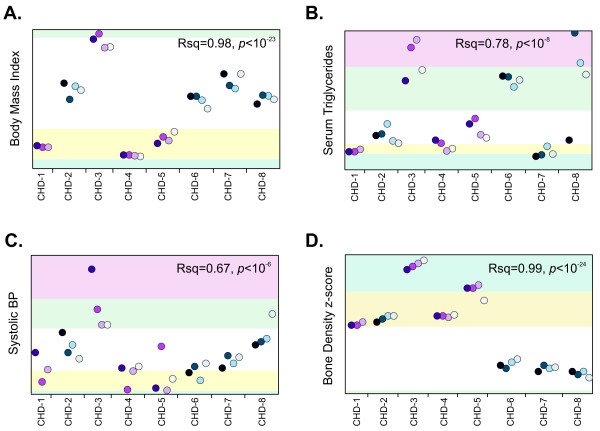
Temporal change in clinical measures in the eight Center for Health Discovery and Well Being (CHDWB) participants: (A) body mass index (BMI), (b) serum triglycerides, (c) systolic blood pressure (SBP), and (d) bone mineral density (BMD). Each plot shows the temporal sequence from first to fourth visit over 3 years (left to right, dark to pale shading) for the four men (blue) and four women (purple) in the study. Data were only available for the first three visits for CHD-1. Adjusted R2 and significance measures refer to ANOVA of the individual differences, providing an estimate of the proportion of variance between individuals for each measure. Background color coding shows very high (pink), high (green), intermediate (white), low (yellow), and very low (blue) risk score categories defined by 1 or 2 standard deviation units from the CHDWB mean. These categories are also used in Figure 3 (see text for specific results). In order to protect participant privacy, actual trait values are not shown, but ranges in the full cohort are 16 to 61 for BMI, 30 to 708 mg/dL for serum triglycerides, 78 to 187 for SBP, and -3 to +3 for BMD z-scores.